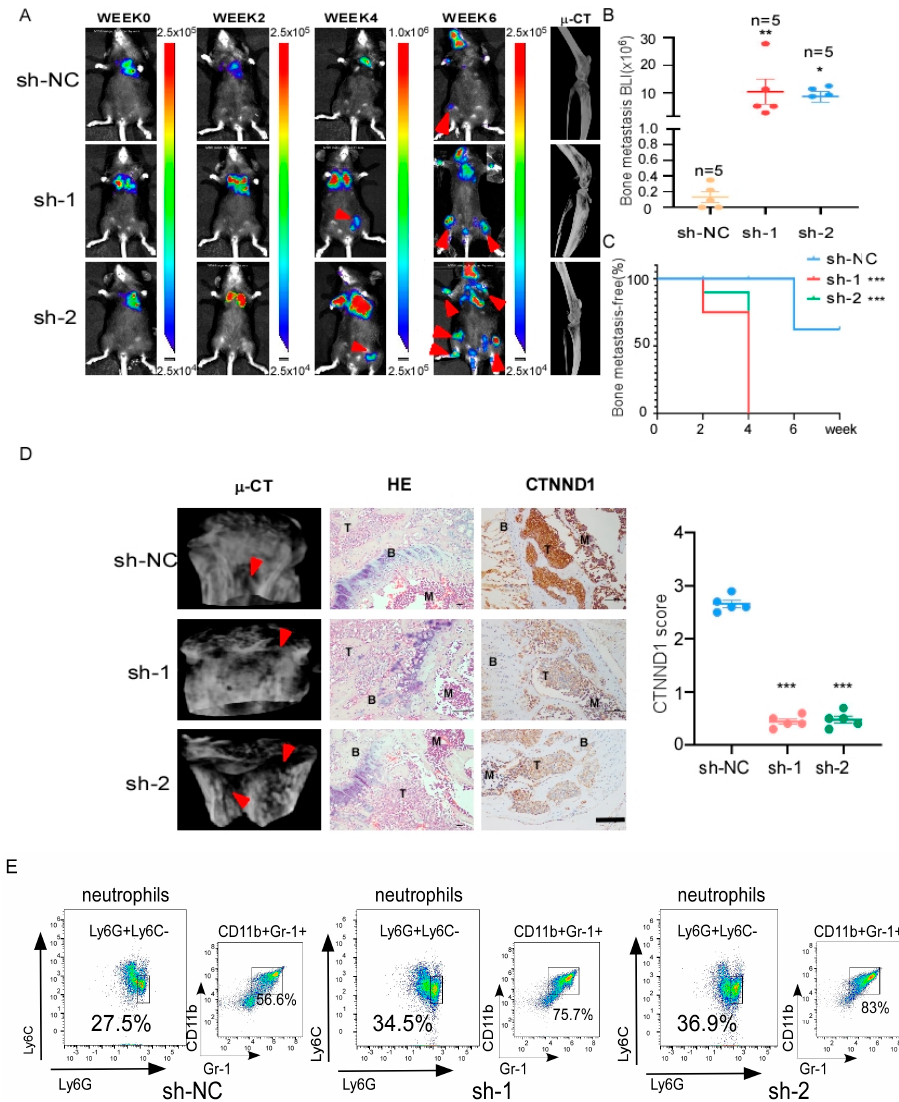
Figure 2. Downregulation of CTNND1 promotes bone metastasis of luciferase-labeled EO771 and immature myeloid cells, especially neutrophils infiltration in bone. ( A ) Representative BLI and µ CT images of bone metastasis in mice. Arrowheads: bone metastasis of tumor cells. ( B ) In vivo quantification of bone metastasis in mice injected with EO771 cells of sh-control, sh-1, sh-2 by BLI (*** p = 0.004, * p = 0.0215). ( C ) Kaplan–Meier bone metastasis-free survival curve ( n = 5/group). ( D ) µ CT images of bone metastasis in mice (left), HE staining of bone metastasis tissues in mice (middle), the expression of CTNND1 in bone metastasis tissues by IHC staining (right). BMD (bone mineral density) and IHC scores were analyzed in the right graphs. Scale bar represents 50 µ m, T: tumor, B: bone, M: bone marrow. ( E ) Representative flow cytometric analysis and quantification of mice bone for infiltrating immature myeloid cells and neutrophils in mice. All experiments were repeated at least 3 times. * p < 0.05, ** p < 0.01, *** p < 0.005. Error bars indicate Standard Error of Mean